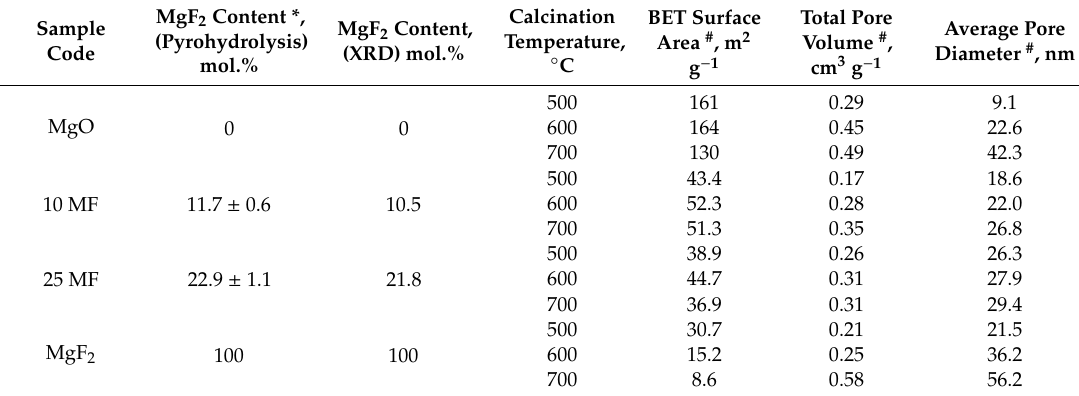
Table 1. Physical characterization of MgO, MgF 2 , and MgF 2 / MgO samples after calcination in air at 500, 600, and 700 ◦ C for 4